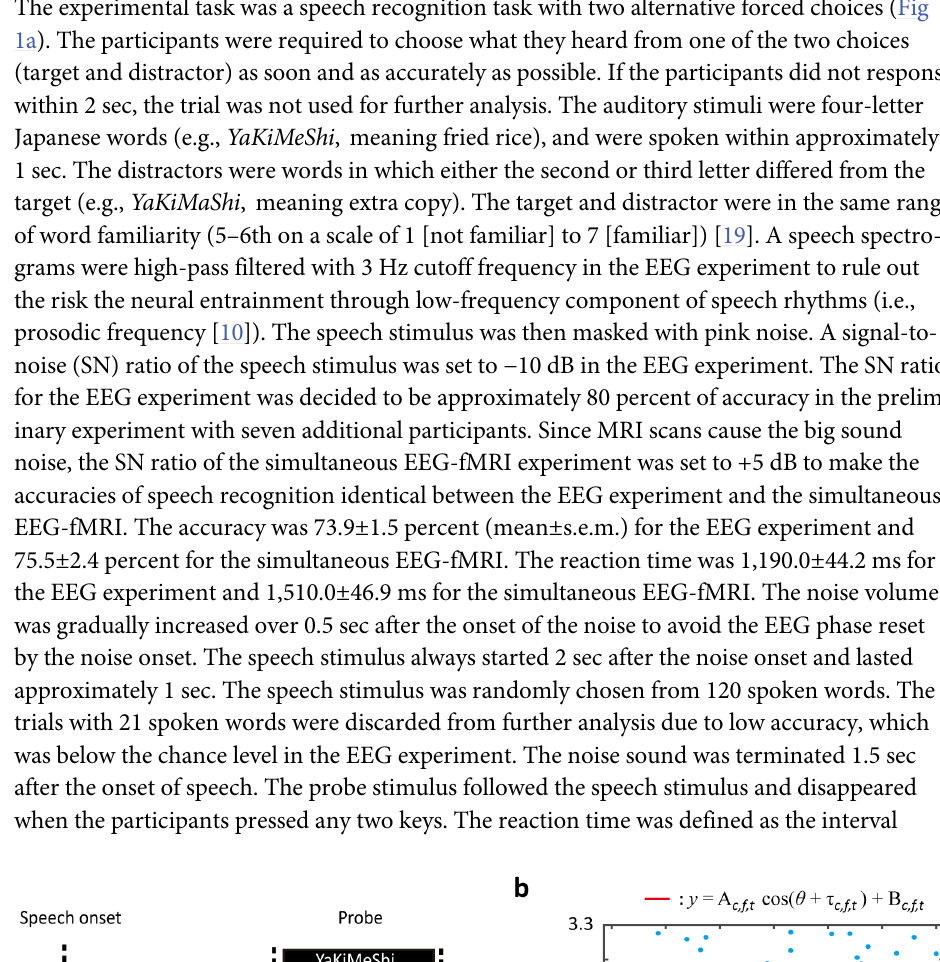
PLOS ONE | https://doi.org/10.1371/journal.pone.0183146 August 11,